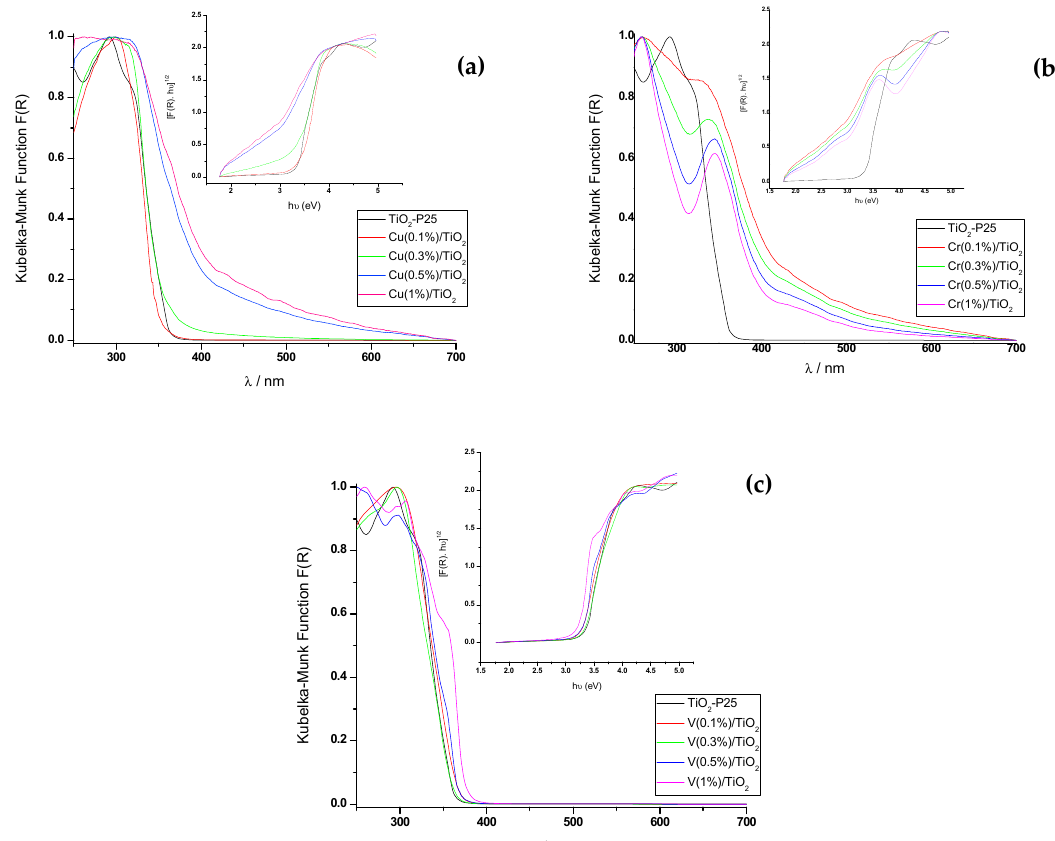
Figure 5. UV-Vis di ff use reflectance (DRS) spectra of M(X%) / TiO 2 photocatalysts. M: ( a ) Cu, ( b ) Cr, and ( c ) V. Figure 5. UV-Vis diffuse reflectance (DRS) spectra of M(X%)/TiO 2 photocatalysts. M: ( a ) Cu, ( b ) Cr, and ( c ) V. Table 2. Band gap values obtained for the metal surface-impregnated TiO 2 photocatalysts. The entries in bold were obtained in this work (M(X%) / TiO 2